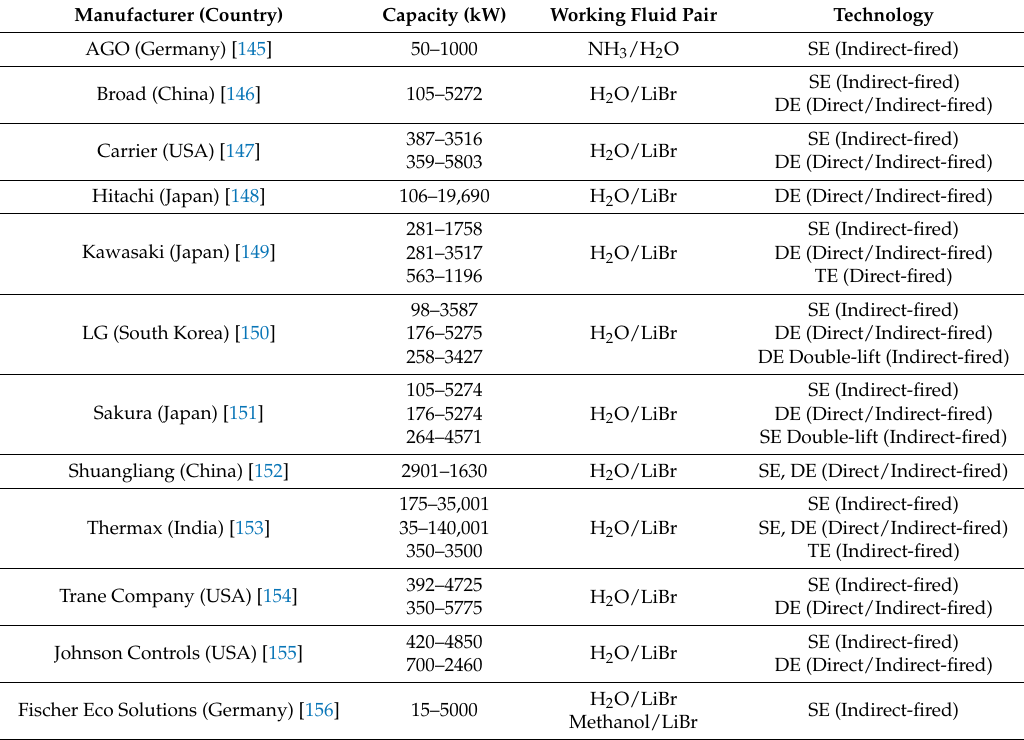
Table A1. Medium–large-capacity, commercially available absorption chillers from leading manufacturers and suitable for DC applications.